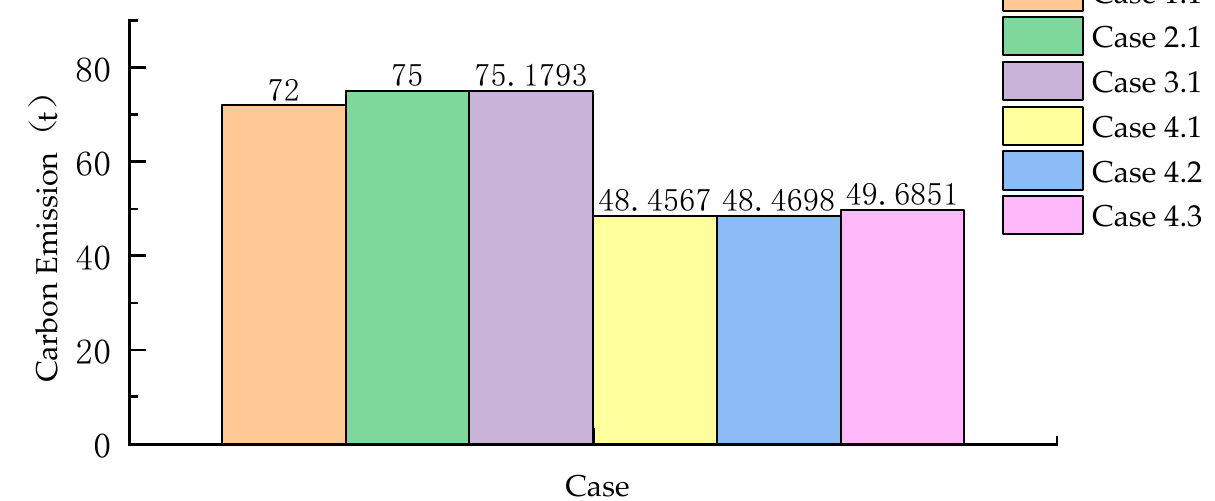
Figure 8. Carbon emission of different cases.